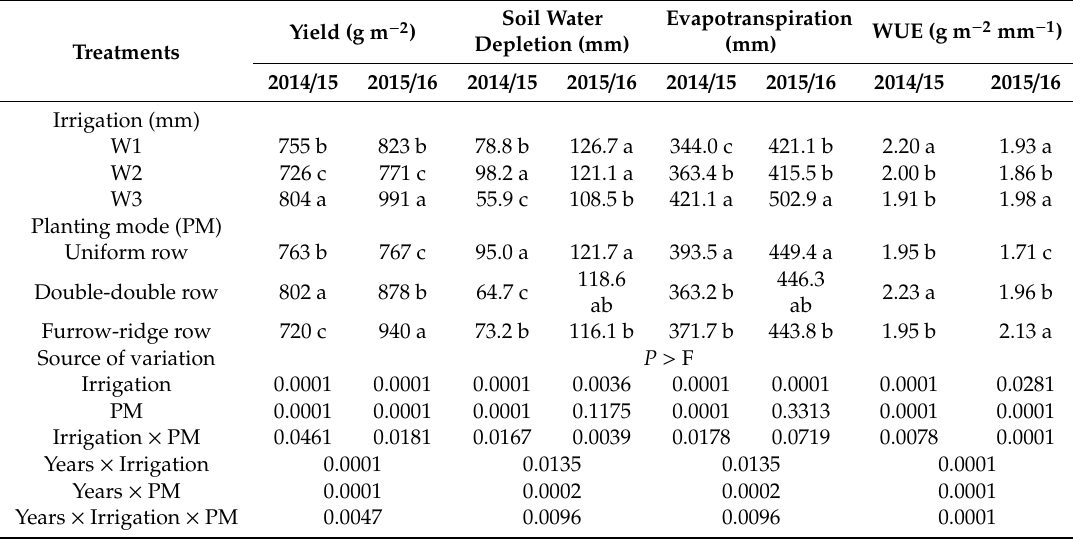
Table 6. E ff ects of planting mode and irrigation on the yield, soil water depletion, evapotranspiration, and water use e ffi ciency (WUE) during the growing season of winter wheat growth in